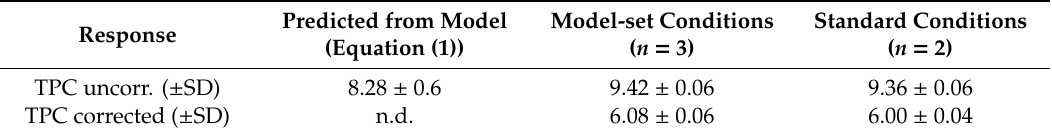
with the empirical model. Corrected TPC values were also assayed for the